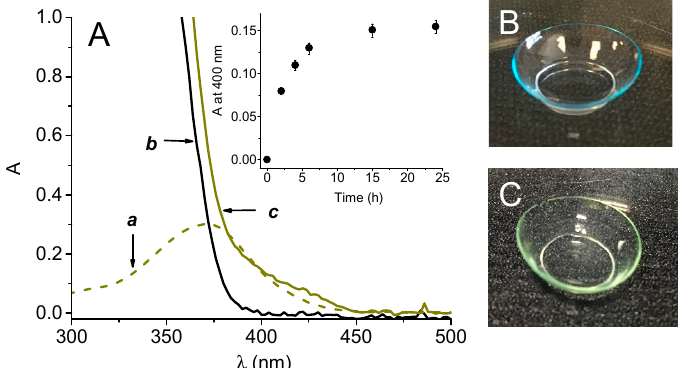
Figure 1. ( A ) Absorption spectra of an ethanol solution of 1 ( a ) and the CL before ( b ) and after ( c ) loading with 1 . ( B ) and ( C ) show the actual images of the CL before and after loading with 1 , respectively.